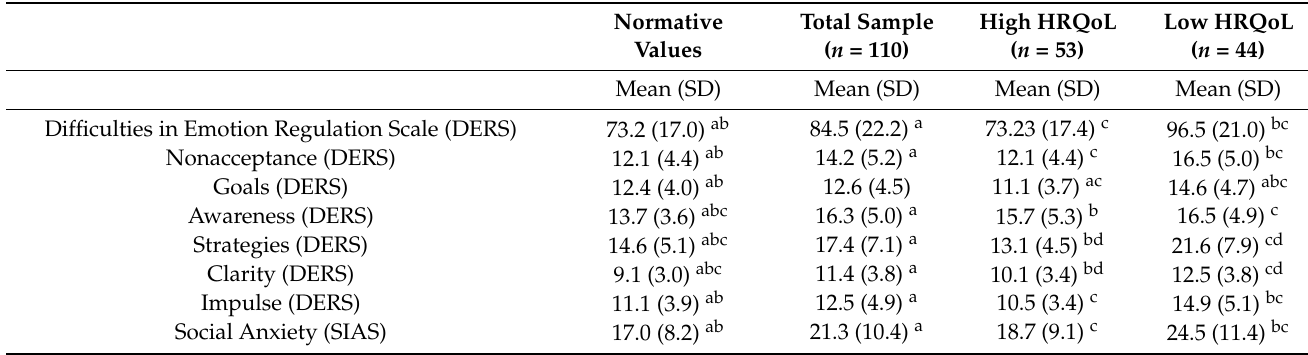
Table 3. Mean (SD) scores reported by general population samples and by patients affected by mild psoriasis in our study reporting high and low levels of health-related quality of life